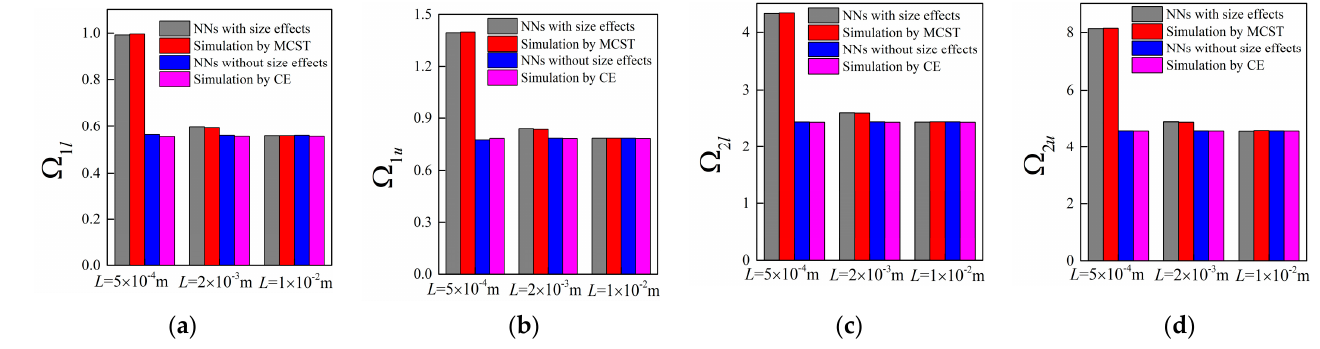
Figure 5. The predictions for bounding frequencies of size-dependent and size-independent band gaps of random example 1: ( a , b ) the lower and upper boundary of the first band gap; ( c , d ) the lower and upper boundary of the second band gap.